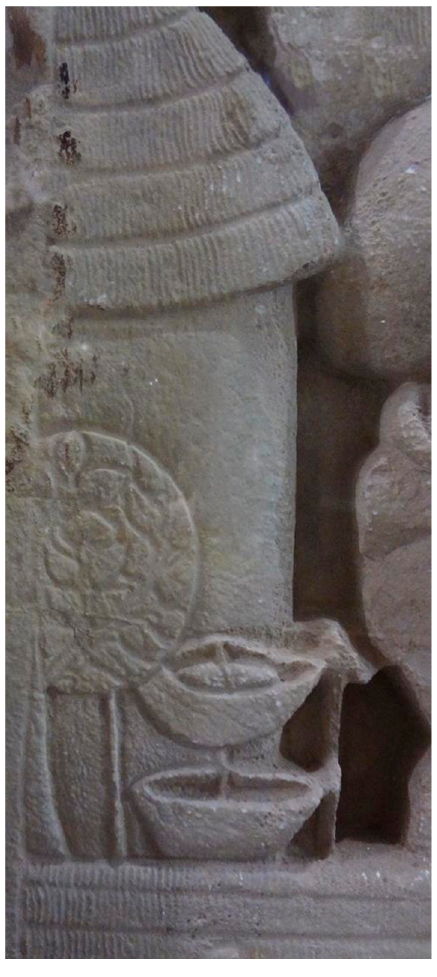
Figure 13. Part of relief no. 124 in Chennai Government Museum © photograph Wojtek Oczkowski.